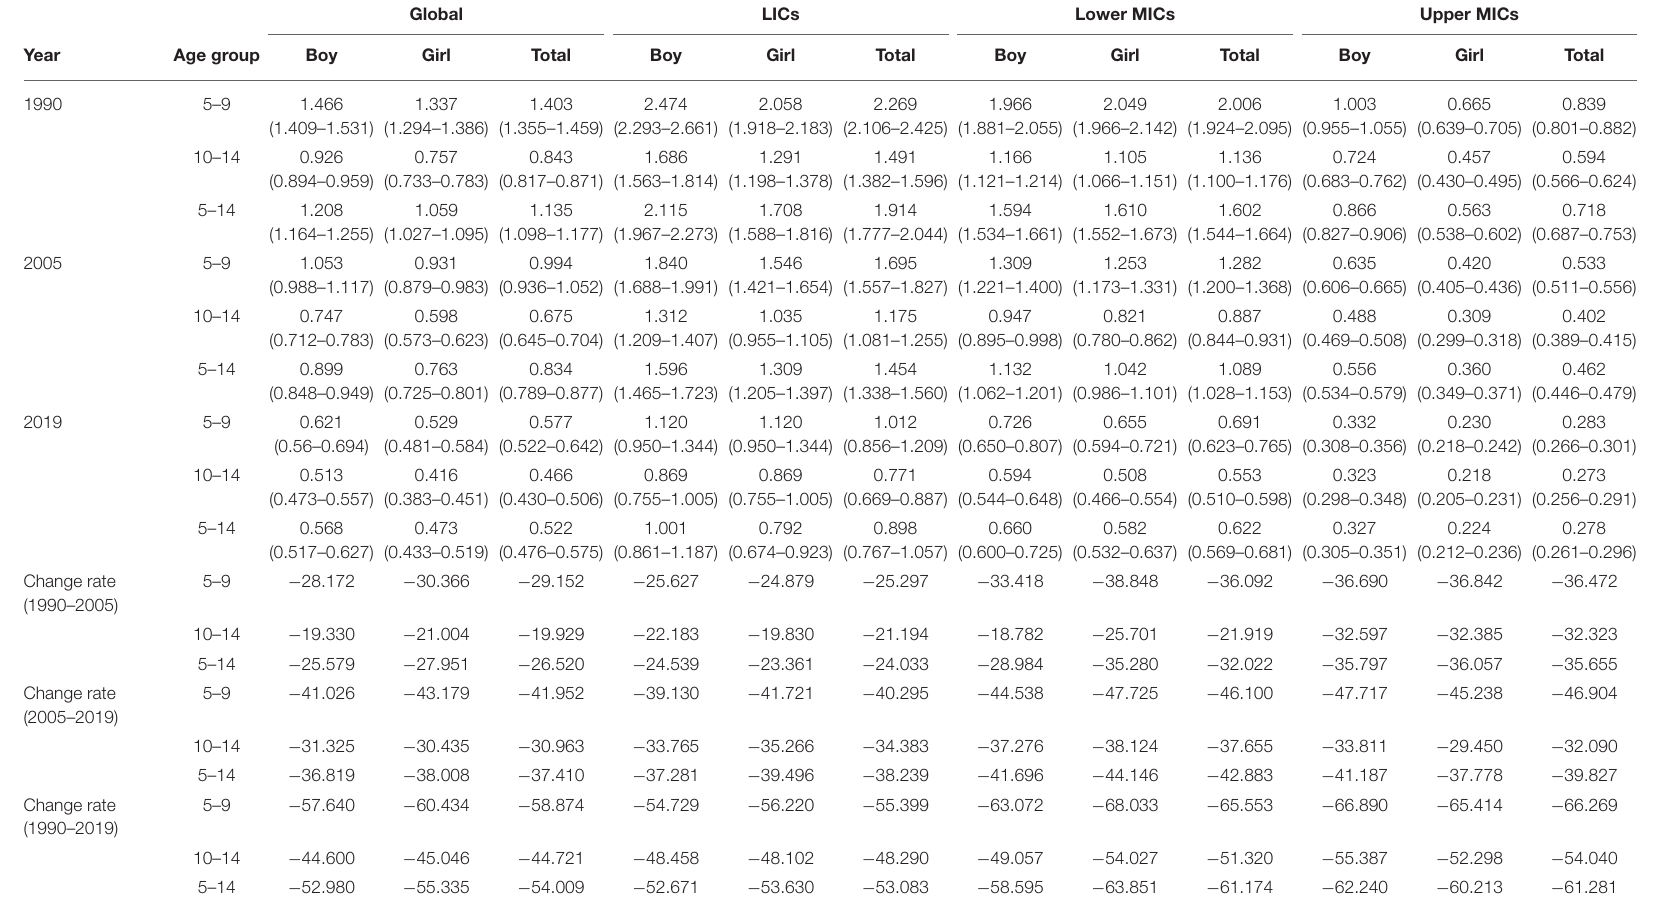
TABLE 1 | Changes in sex- and age-specific mortality rates in children aged 5–14 years in specific regions from 1990 to 2019.